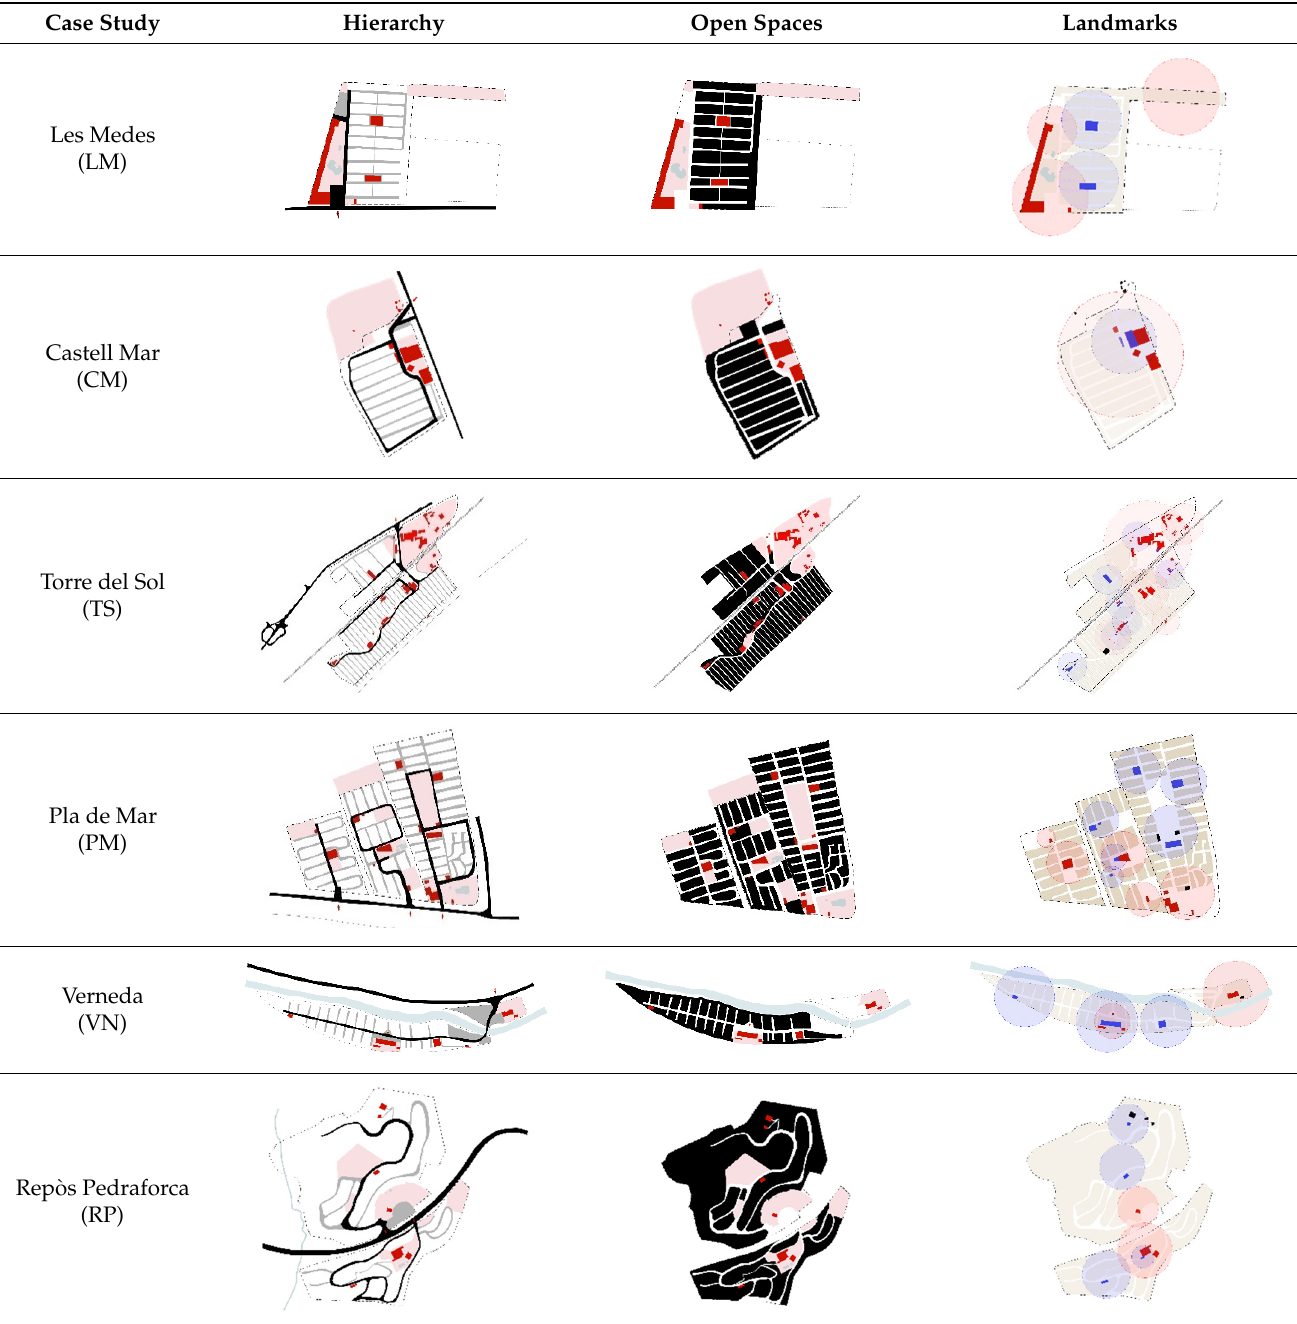
14 of 24 Figure 5. Location plans and landscape values. Scale 1/5000, DinA3, vertical north (Source: authors’ own). ( A ) Campsite Les Medes; ( B ) Campsite Castell Mar; ( C ) Campsite Torre del Sol; ( D ) Campsite Pla de Mar; ( E ) Campsite Verneda; ( F ) Campsite Repòs Pedraforca. In the other four approach levels, Layout, Clusters, Pavilions and Artifacts, the settlements are analyzed as projected entities, with their structure and characteristics defined from the architecture to enhance their belonging to their immediate context. In this phase, the comparative analysis is based on the mapping of the case studies, by means of simple and intelligible diagrams [79]. Each map is thematic and focuses exclusively on one aspect of the analysis [80]. In this way, the comparison between the equivalent diagrams facilitates the recognition of the common situations in the different study cases, as well as the singularities to adapt the settlement to its specific environment (Table 3) [81].